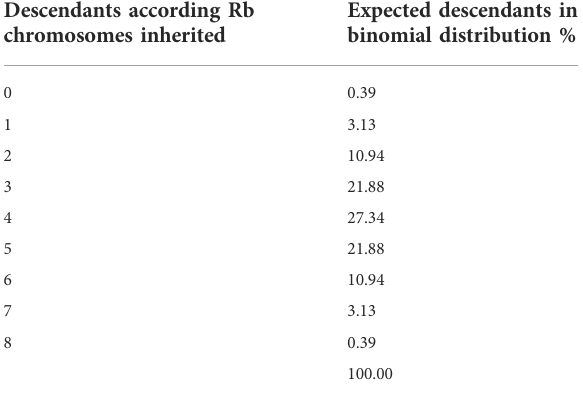
TABLE1Expected frequencies oftheappearanceofoffspringwith the 0 to 8 Rb chromosomes, calculated on the theoretical binomial distribution with probability p = 0.5.